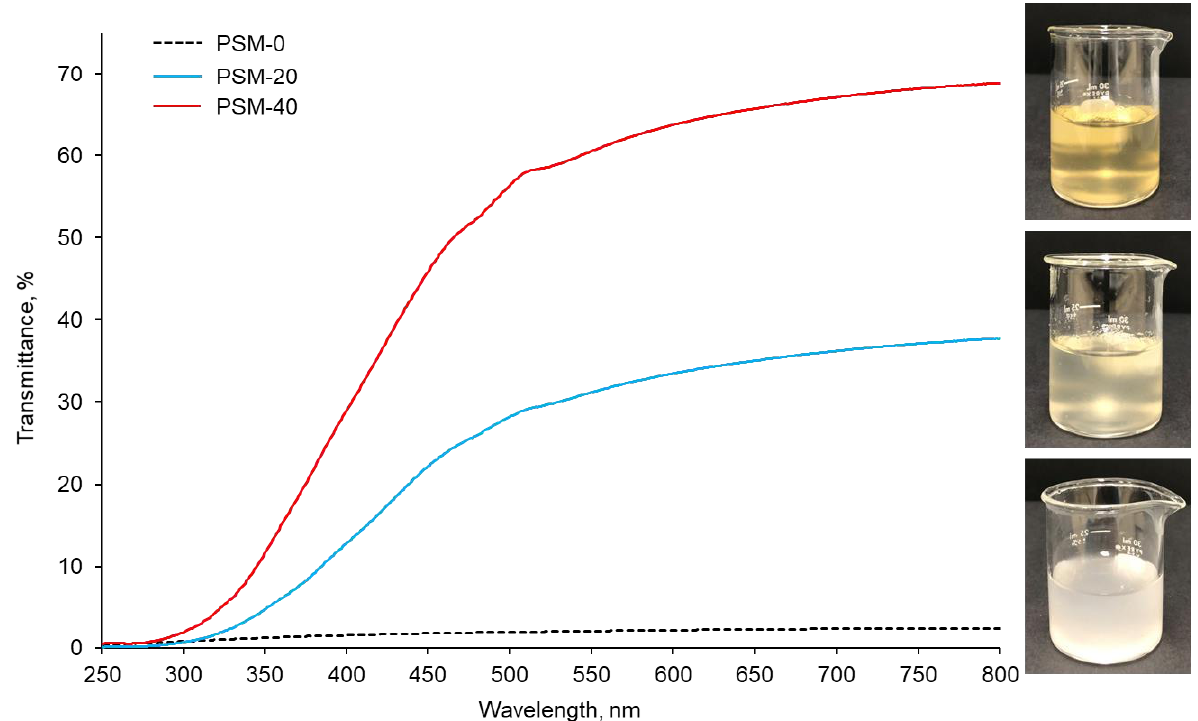
Figure 2. UV-vis light transmittance collected from the control and plasma treated cotton fibers (PSM-0 (control), PSM-20, and PSM-40) dissolved in NaOH/urea solvent system for 30 min (1% w / v ). Inset shows the corresponding visual images of cellulose/NaOH/urea solutions.